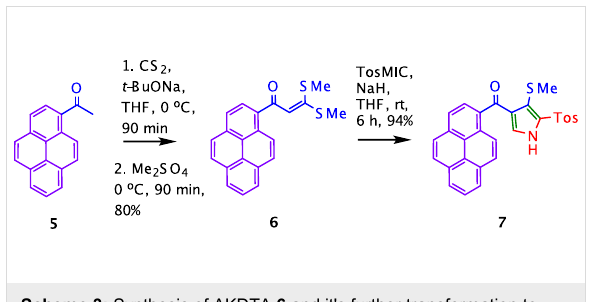
Scheme 3: Synthesis of AKDTA 6 and it's further transformation to pyrrole 7